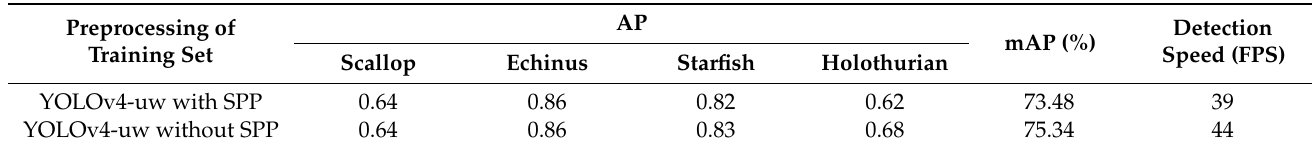
Table 2. Comparison of YOLOv4-uw with and without SPP.